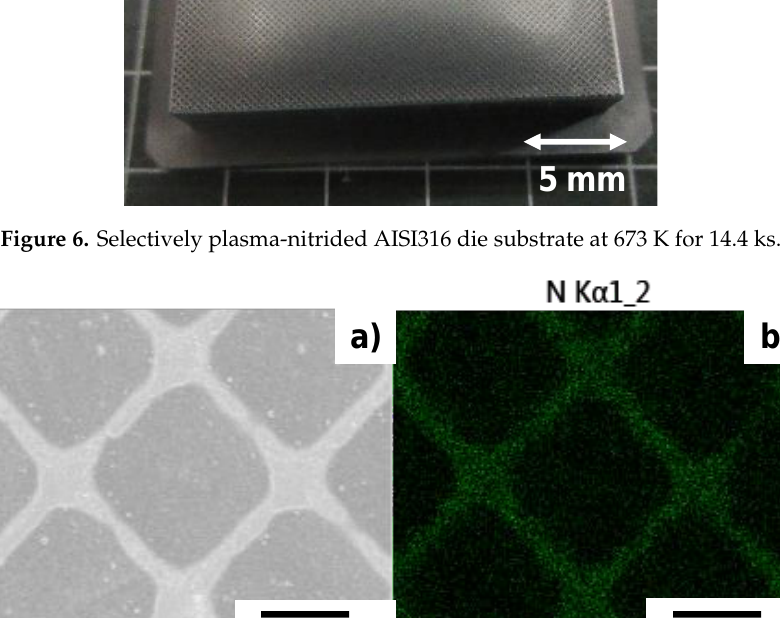
Figure 7. Microstructure of plasma-nitrided AISI316 die surface at 673 K for 14.4 ks. ( a ) SEM image and ( b ) nitrogen mapping by EDX.